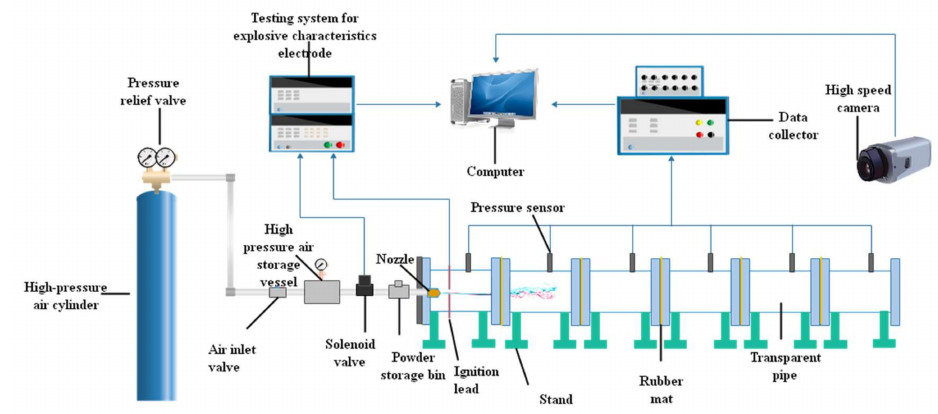
Figure 7. The transparent pipeline explosion propagation system. As the mass of mixed dust changed with the addition of the inhibitor, it was necessary to use a high-speed photography to debug various parameters (primarily the initial ignition energy E, ignition time delay t, and initial spray pressure P 0 ) to keep the mass concentration of the dust unchanged while exploding in the pipeline. As shown in Figure 8, before ignition, the dusting length of pure oil shale dust at 20 ms reached 1 m. After 20 ms, the dust cloud began to segment in the pipeline and a lot of dust was deposited at the bottom of the pipeline. Thus, if ignition began at that time, the dust cloud could not fully participate in the explosion reaction. Therefore, experimenting with parameters for complete dust cloud state could ensure the best state of dust explosion. As calculated, the explosion concentration of 9 g of oil shale dust in the pipeline at 20 ms was 509 g/m 3 . In order to control the explosion concentration of mixed dust in the pipeline to around 500 g/m 3 , the experimental parameters of mixed dust were debugged using high-speed photography, and experimental parameters shown in Table 2 were